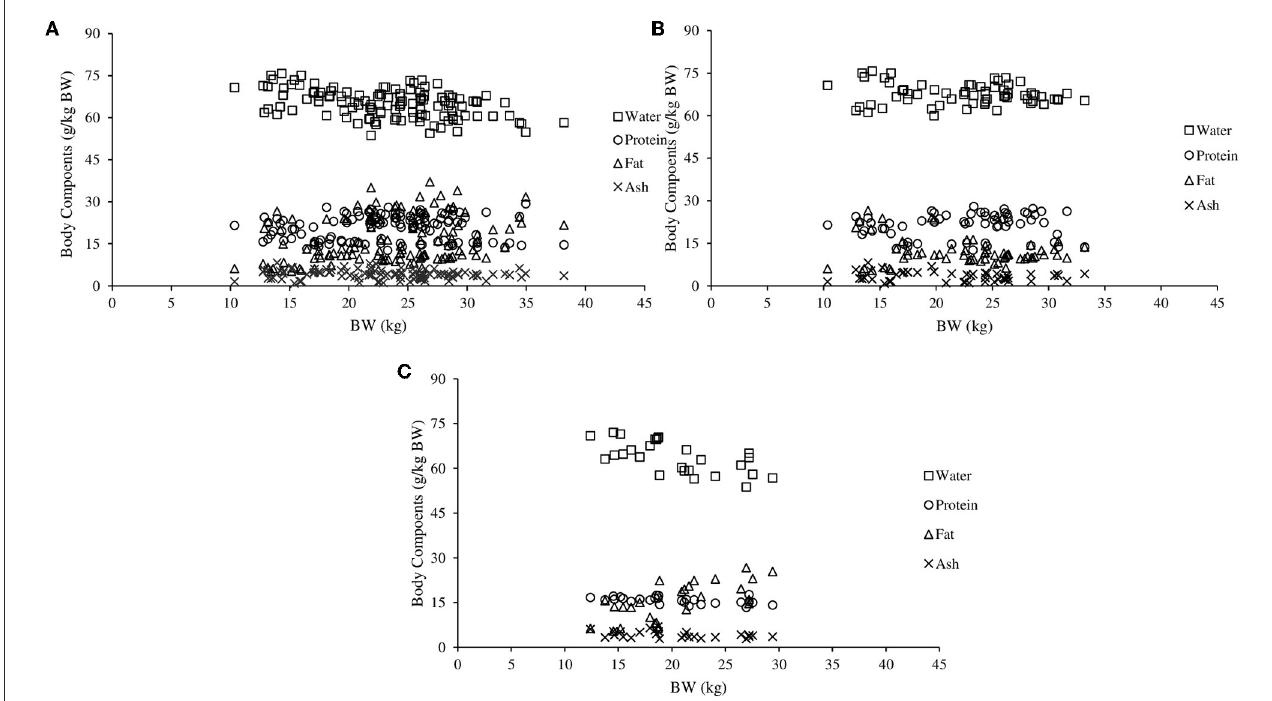
FIGURE1 Proportions of water, protein, fat and ash in non-castrated males (A) , castrated males (B) , and females (C) hair sheep.